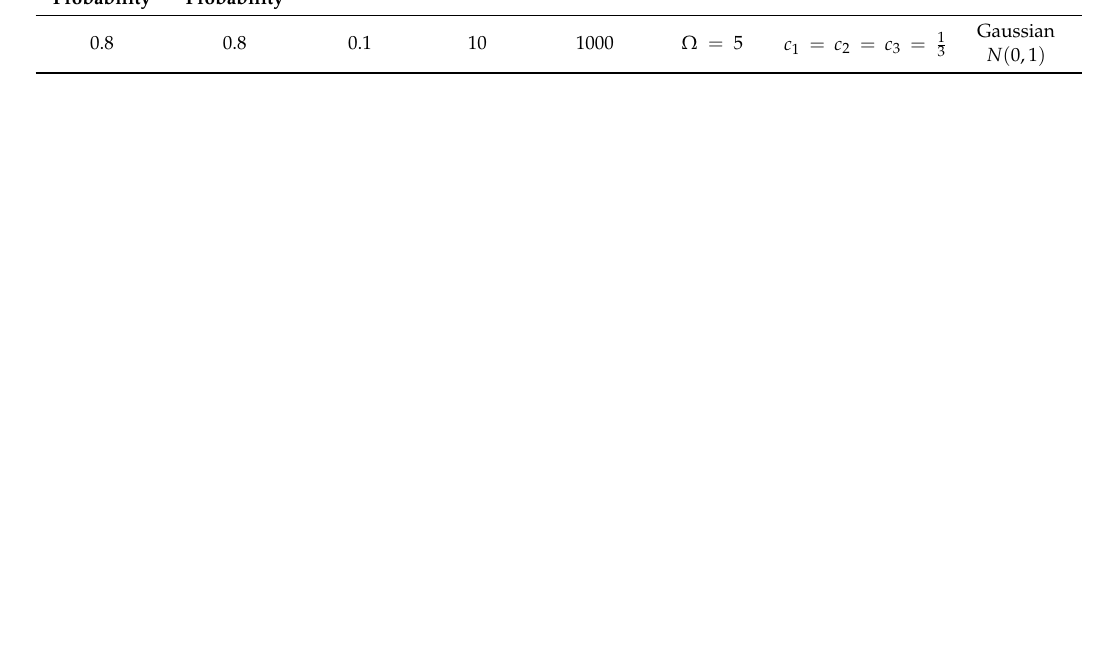
Figure 19. The experiment results in the scenario with 8 stations and 6 tasks ( c 1 = c 2 = 0.1, c 3 = 0.8): ( a ) fitness curve; ( b ) PDOP curve; ( c ) completion rate curve; ( d ) resource utilization curve.